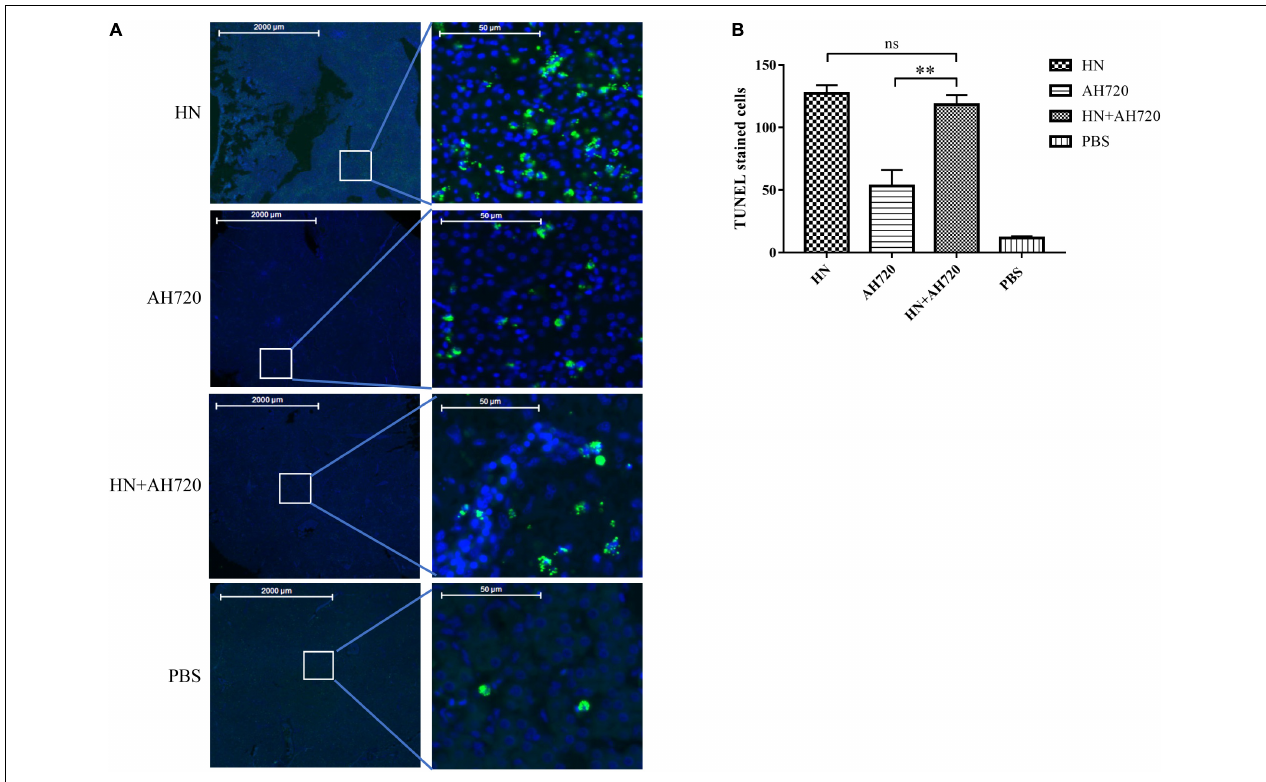
FIGURE 6 | TUNEL staining of livers of the chickens from different infection groups. (A) TUNEL staining of livers of chickens from four infection groups. (B) Quantification of the TUNEL stained cells. The slides of liver samples were incubated with 50 µ l of TUNEL reaction mixture at 37 ◦ C for 60 min in a humid atmosphere. The TUNEL intensity was examined and captured by Pannoramic confocal 3D HISTECH system and analyzed by PanoramaStudio Pro software. The TUNEL-positive cells were counted and the average number was compared. The error bars indicate SEM. ns represents not significant, ∗∗ P < 0.05 (Student’s t